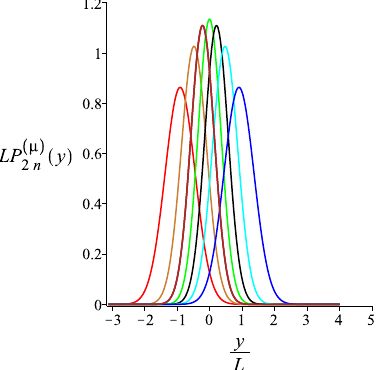
+ π i , 2 6 = 12.5, , φ µ = 0, l p L 4